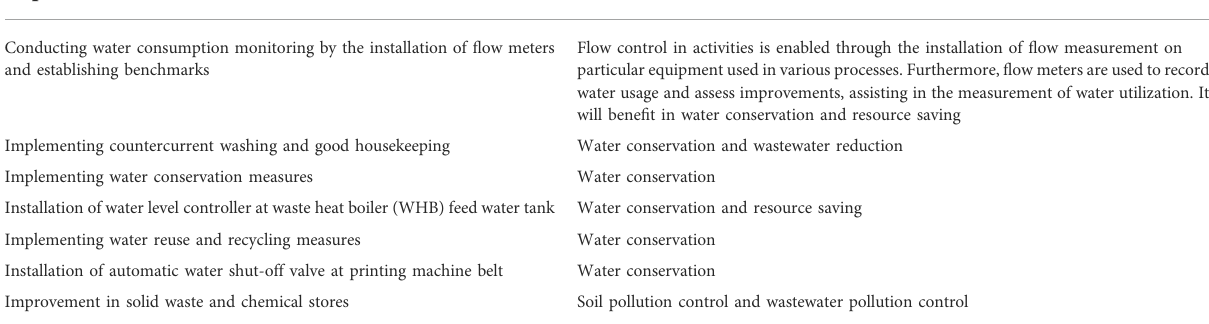
TABLE 4 Smart environmental management practices (SEMPs) and their bene fi ts for water. Implemented